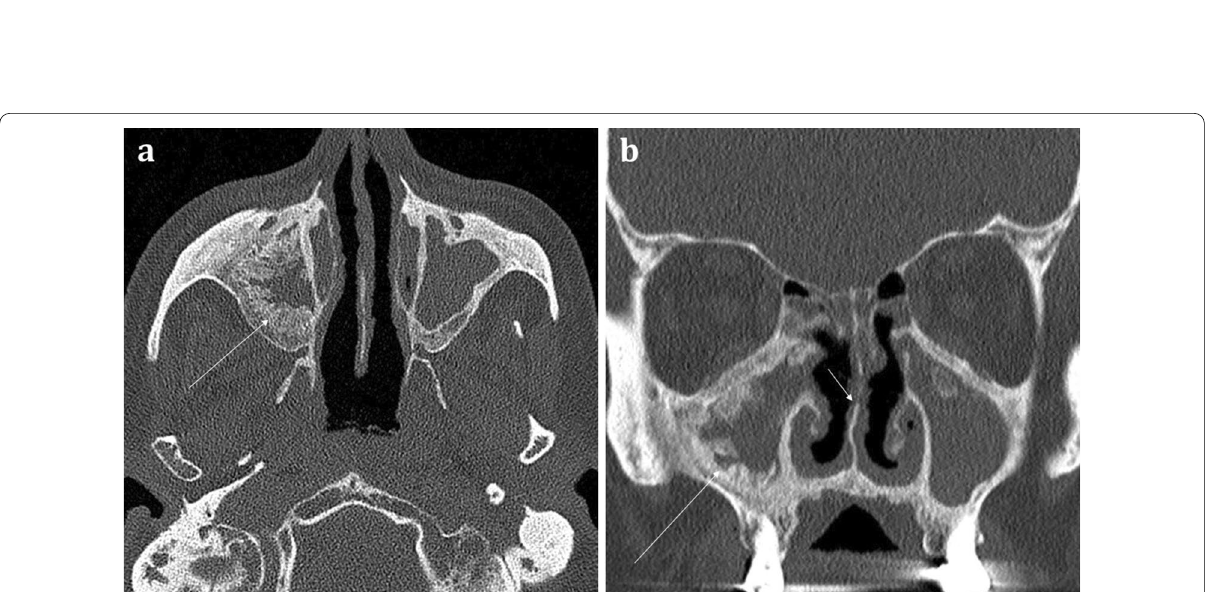
Fig. 9 Axial ( a ) and Coronal ( b ) bone window CT images of a 71-year-old patient with known granulomatosis with polyangiitis (GPA) suffering from chronic nasal obstructive symptoms and nasal crusting. There is widespread mucosal thickening throughout the sinuses with evidence of “frond-like” chronic remodelling and osteitis (long arrows). On the coronal image ( b ), erosion of the middle turbinates and irregularity of the nasal septum can be seen (short